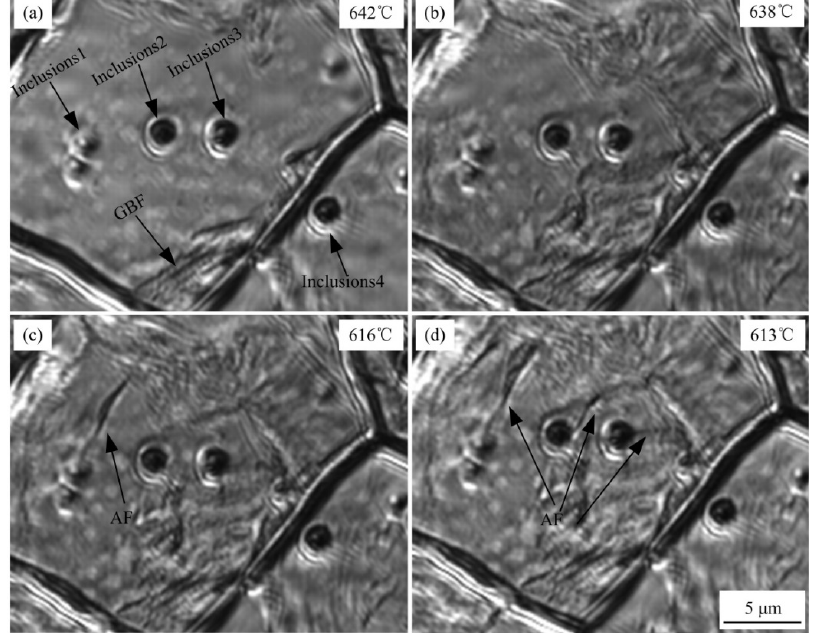
Figure 10. Microstructural evolution during γ → α phase transformation in the weld metal at the cooling rate of 1 ◦ C/s. ( a ) cooled to 642 ◦ C, ( b ) cooled to 638 ◦ C, ( c ) cooled to 616 ◦ C, ( d ) cooled to 613 ◦